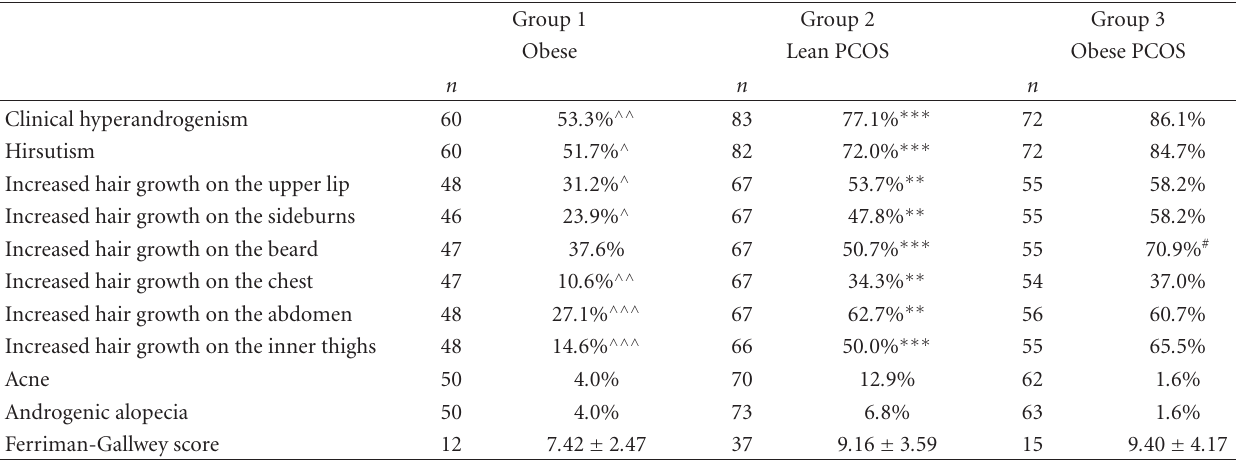
Table 6: Comparison between the data about clinical hyperandrogenism between the three